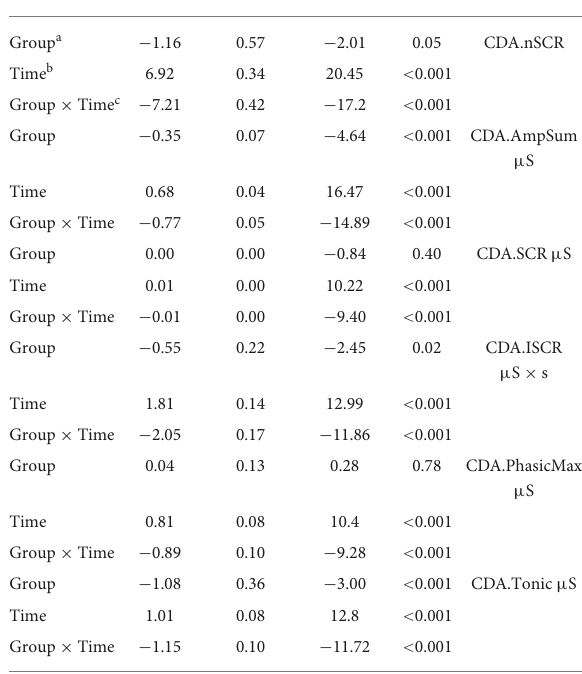
TABLE 5 Linear Mixed effect models about results obtained from